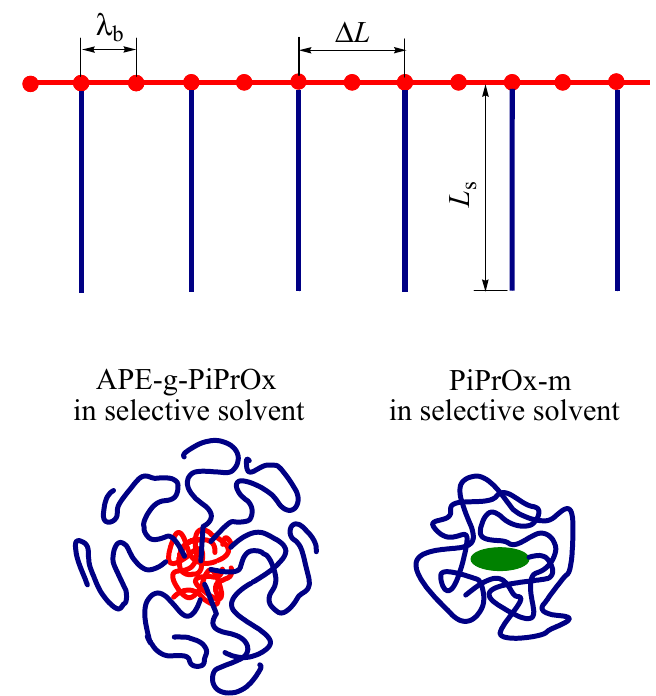
Figure 7. Scheme of the APE-g-PiPrOx molecules and conformation of molecules of APE-g-PiPrOx and linear PiPrOx-m in a selective solvent.